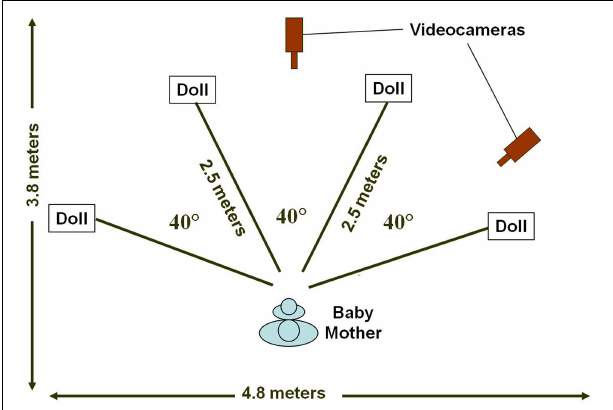
FIGURE 1 | Schematic of the experimental setup. Drawing not to scale.